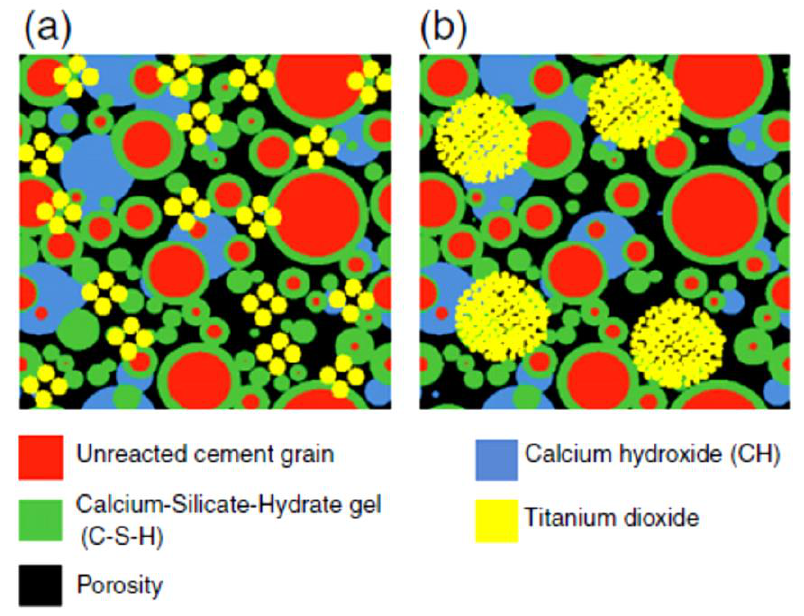
Figure 12. Hardened cement structures containing ( a ) micro- and ( b ) nano-sized TiO 2